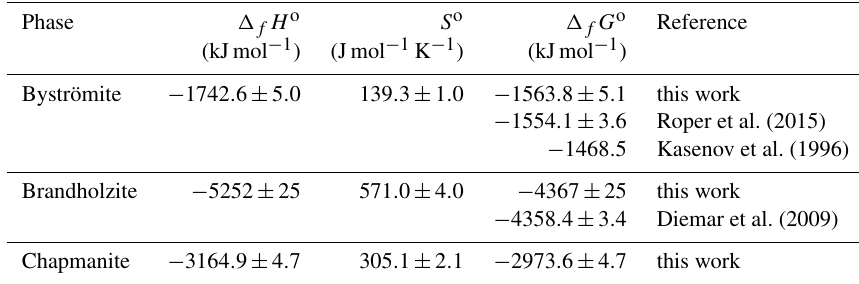
Table 8. Summary of thermodynamic data from this work, compared to previously published data.